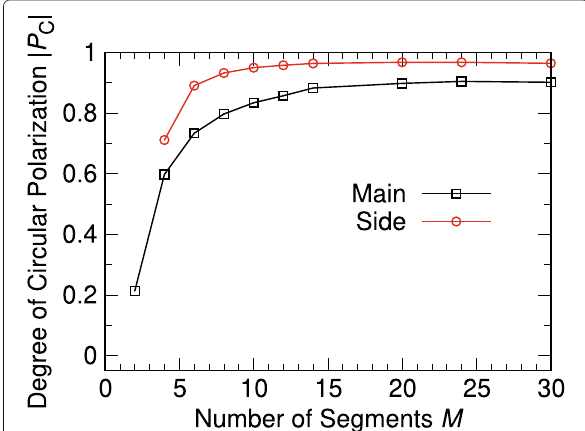
Fig. 5 The dependence of the degree of CP | P C | on the number segments M . P C of the main and high-energy side peaks are shown by the black and red lines, respectively. The energy of the main peak is independent on the number of segments, and P C of the main peak was obtained at the constant energy, ω 1 . The energy of the side peak varies for the different number of segments, and P C of the side peak was obtained at each peak position. The sign of P C in the main and side peak is opposite